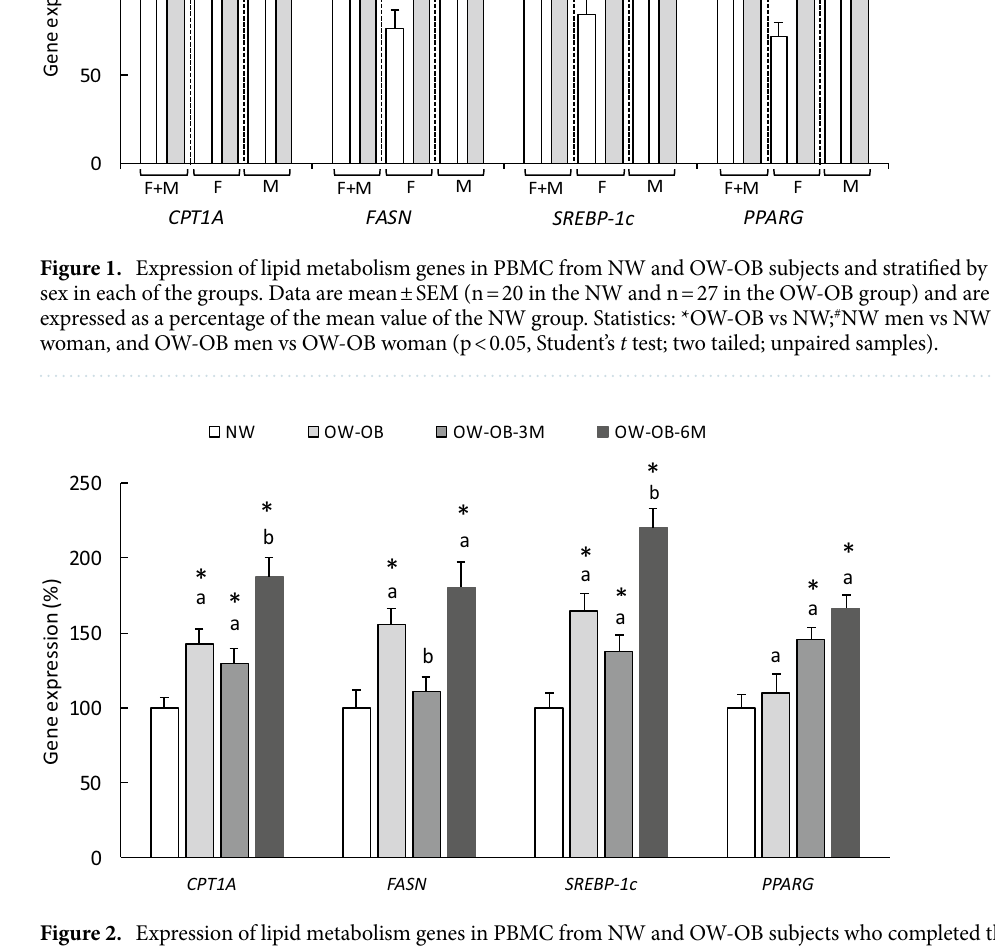
Figure 2. Expression of lipid metabolism genes in PBMC from NW and OW-OB subjects who completed the weight-loss intervention, at 3 and 6 months (OW-OB-3M and OW-OB-6M). Data are mean ± SEM (n = 20 in the NW and n = 20 in the different OW-OB groups) and are expressed as a percentage of the mean value of the NW group. Statistics: within the OW-OB groups, values not sharing a common letter ( a , b ) are significantly different (repeated measures ANOVA, p < 0.05); no letter indicates no significant differences; * indicates values significantly different vs NW group (p < 0.05, Student’s t test; two tailed; unpaired